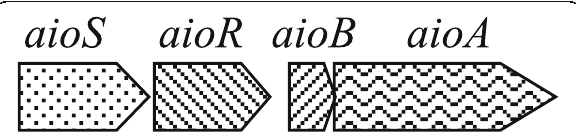
Fig. 9 Operon structure for arsenite oxidation viewed 5 ′ -3 ′ direction on the plus strand. The gene order is the same in both Bosea